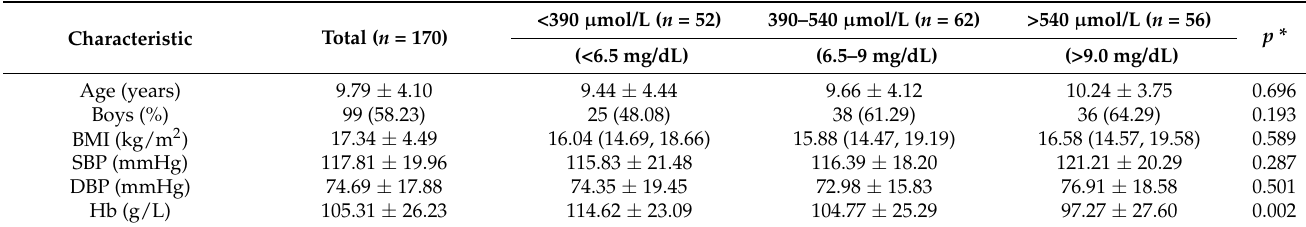
Table 1. Characteristics of the study population by category of serum uric